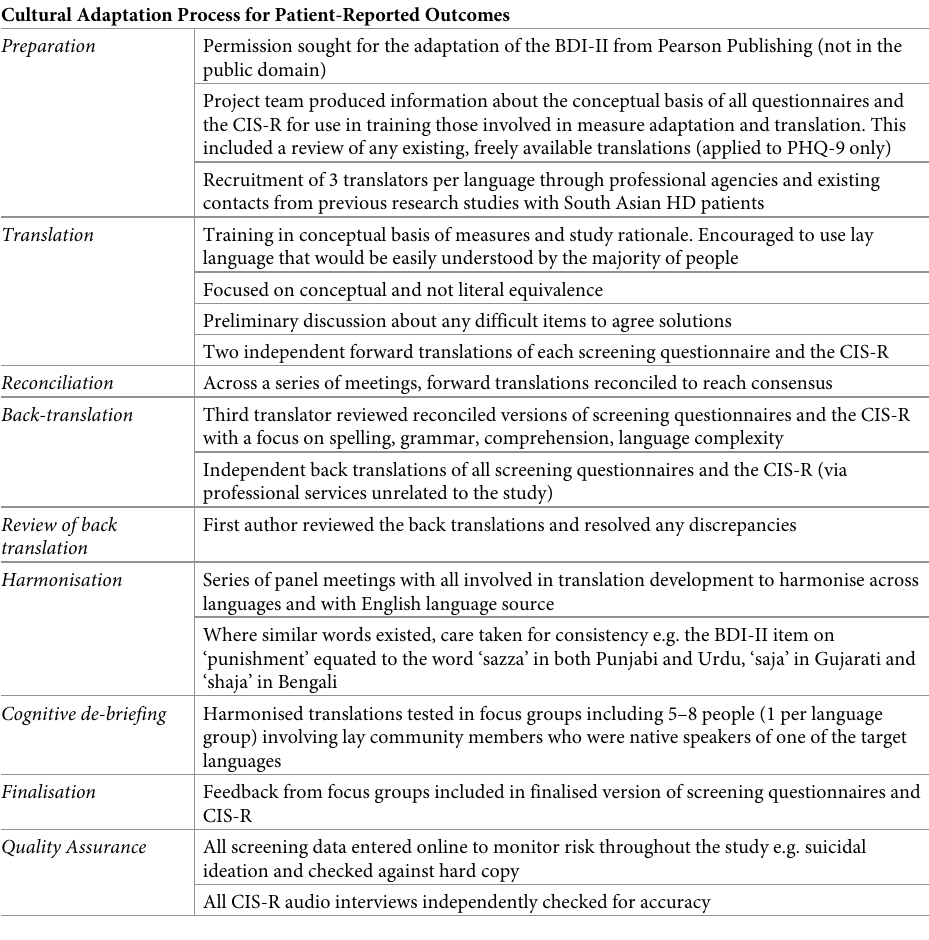
Table 1. Summary of adaptation and translation of questionnaire and diagnostic